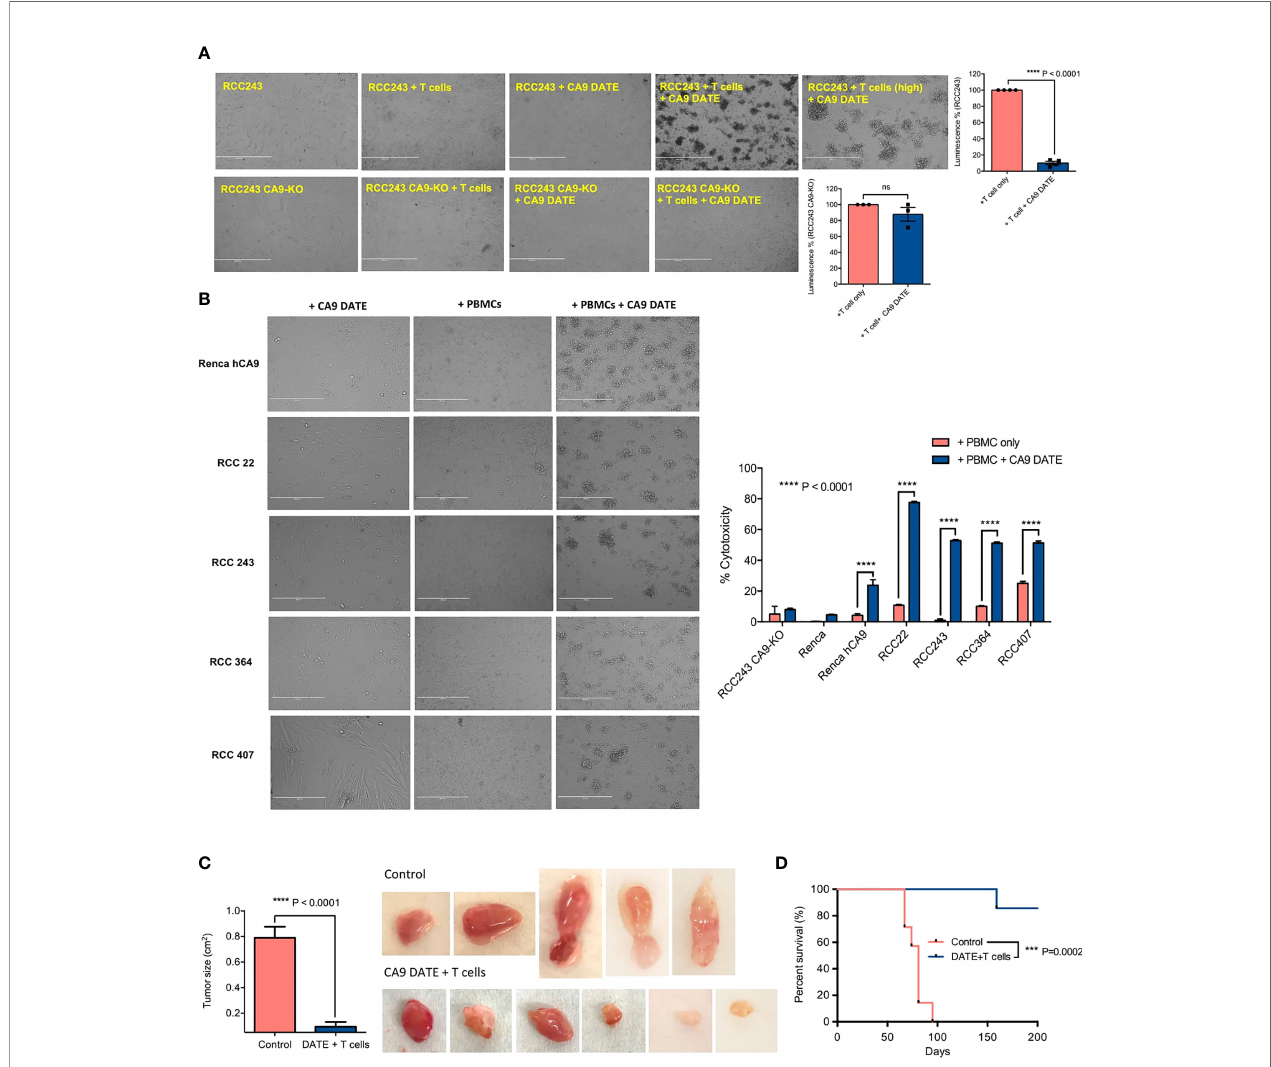
FIGURE 4 | Assessing the ef fi cacy of CA9 DATE in therapeutic targeting of CA9 expressing RCC lines and xenografted immunocompromised mice: (A) CA9 DATE (1 nM) induced potent cytolysis in antigen expressing target cells when cocultured with human CD3+ T cells at an E:T ratio of 5:1 for 48 hours quanti fi ed by luminescence assay. Phase contrast images of the in vitro cytotoxicity assay con fi rmed potent cytolytic effect of CA9 DATE on CA9 antigen expression. (n=4) (Scale bar: 1000 µ) (P value: ****< 0.0001, ns, non-signi fi cant) (mean SEM, two-tailed t-test). (B) CA9 DATE effectively induced target lysis across a panel of kidney cancer cell lines when co-cultured with CD3+ T cells at E:T ratio of 10:1 (In vitro cytotoxicity assay setup as described earlier). lactate dehydrogenase (LDH) release assay on the supernatant indicated a drastic increase in target cell cytotoxicity in the presence of CA9 DATE and CA9 antigen expression. The phase contrast images of light microscope con fi rmed the cytolytic effect of CA9 DATE on CA9 expressing RCC lines (n=2). (P value:****< 0.0001) (2 way ANOVA). (C) NSG mice were subcutaneously implanted with human CA9+ RCC 243 VHL mut cells. Upon successful engraftment and having a palpable tumor, mice were intratumorally treated with 2x10 6 T cells isolated from human PBMCs either with CA9 DATE or CA9 DATE control (50µg) for a total of 12 doses over 6 weeks. Mouse xenografts generated after CA9 DATE treatment had less tumor burden (n=6) (P value: **** < 0.0001) (mean±SEM, two-tailed t-test) and (D) maintained a signi fi cant survival advantage over control mice (n=7) (P value: *** < 0.0004) (Log-rank Mantel-Cox